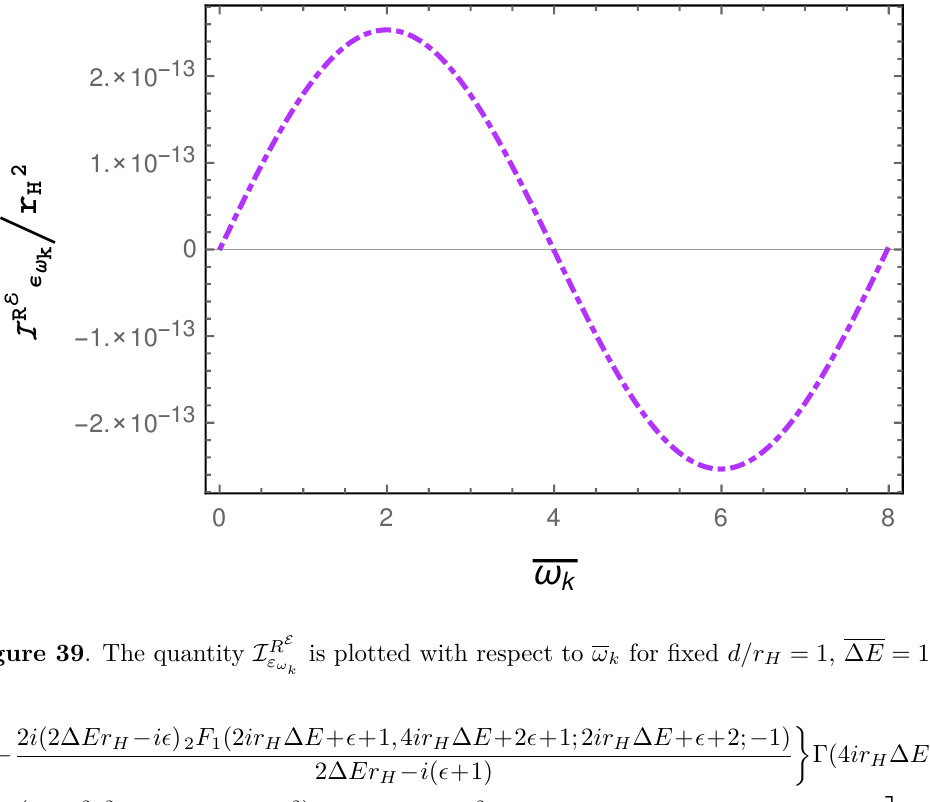
Figure 39 . The quantity I R E